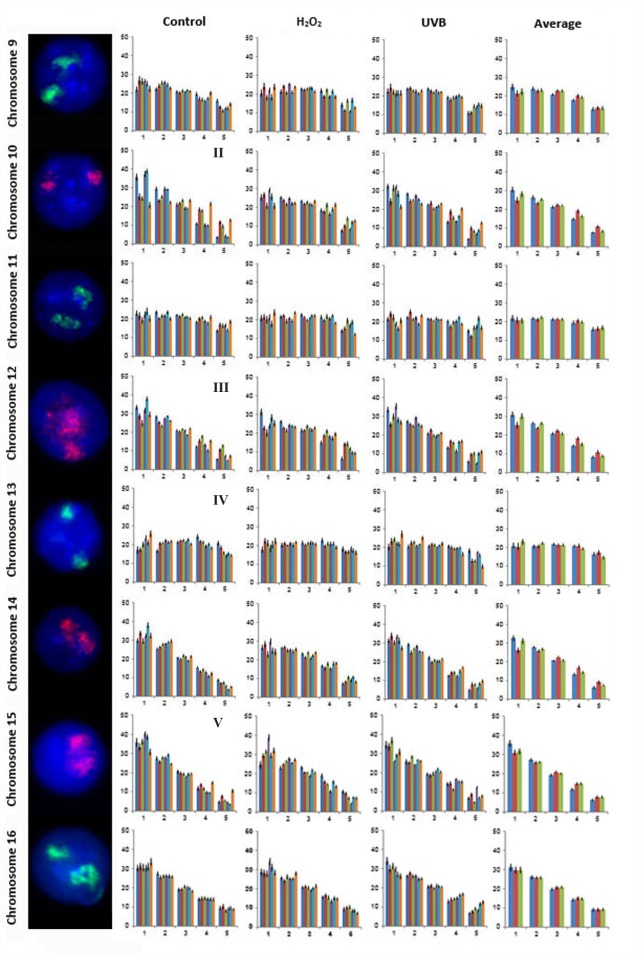
Radial distribution for chromosomes 9–16 in six subjects in unexposed, H2O2 and UVB exposed lymphocytes.
Fig. 3 displays representative FISH images and the radial distribution for CTs 9–16. As in Fig. 2 moving from left to right the chromosome number is indicated followed by a representative FISH image for the CT and four histograms. Each histogram displays the proportion of fluorescence (%) from the nuclear interior toward the nuclear periphery (left to right). The first, second and third histogram displays the radial distribution for each CT in control, H2O2 and UVB exposed lymphocytes, respectively for each of the six subjects (1 to 6, left to right). The fourth histogram displays the average radial distribution for the six subjects in unexposed (blue), H2O2 (red) and UVB (green) exposed lymphocytes. Error bars represent the standard error of the mean (SEM). Roman numerals indicate significant inter-individual variations in radial distributions (p<0.05) between subjects in control lymphocytes: II- CT10 subjects 1, 4 and 5 (different to subjects 2, 3 and 6); III- CT12 subject 3 (different to subjects 1 and 5); IV- CT13 subject 6 (different to subject 1); V- CT15 subject 6 (different to subject 4).